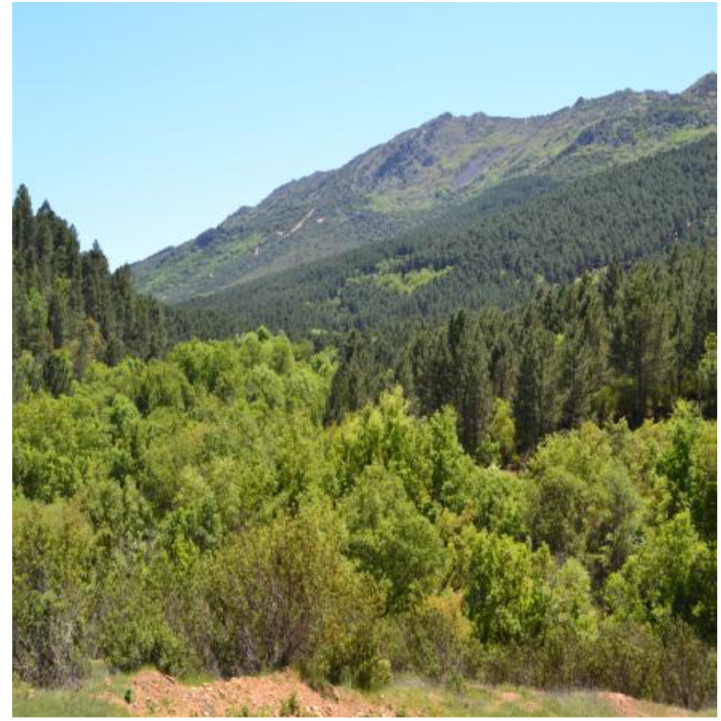
Figure 12. Pyro bourgaeanae – Quercetum broteroi.